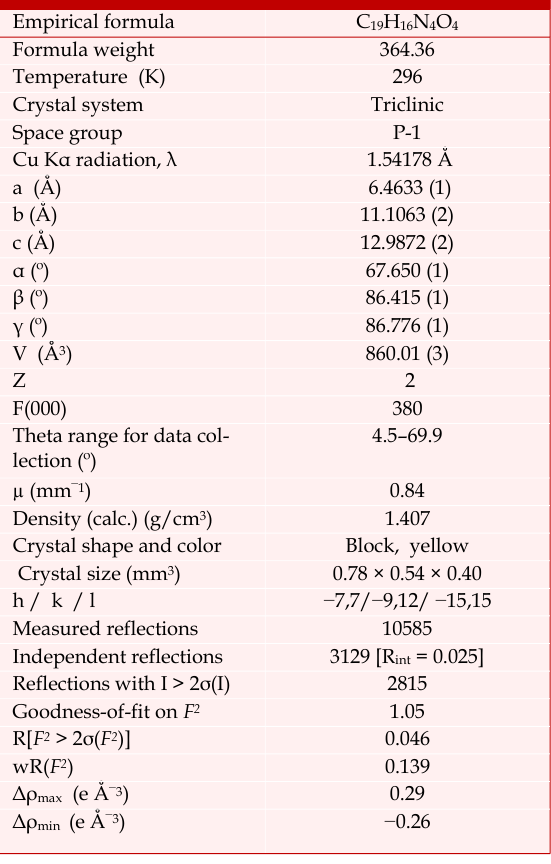
Anti-Candida agents: Stock solution (1,000 µg/mL) of test compound 4 as well as fluconazole were prepared in 100% dimethylsulfoxide and were diluted with sterile distilled water. Fluconazole antifungal discs were stor- ed at – 80°C until used. Organisms: Two clinical isolates of Candida species were Saudi Arabia, one identified as C . albicans and the other